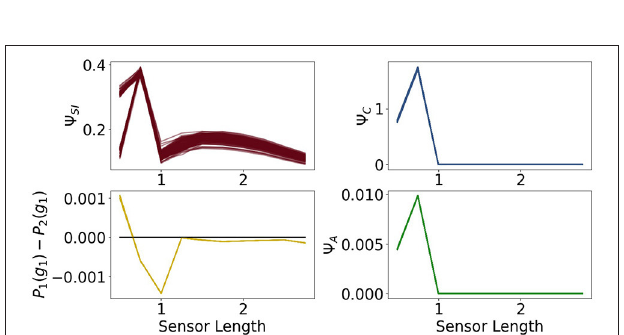
FIGURE 14 | Integrated information and morphological computation for the reactive control agents.